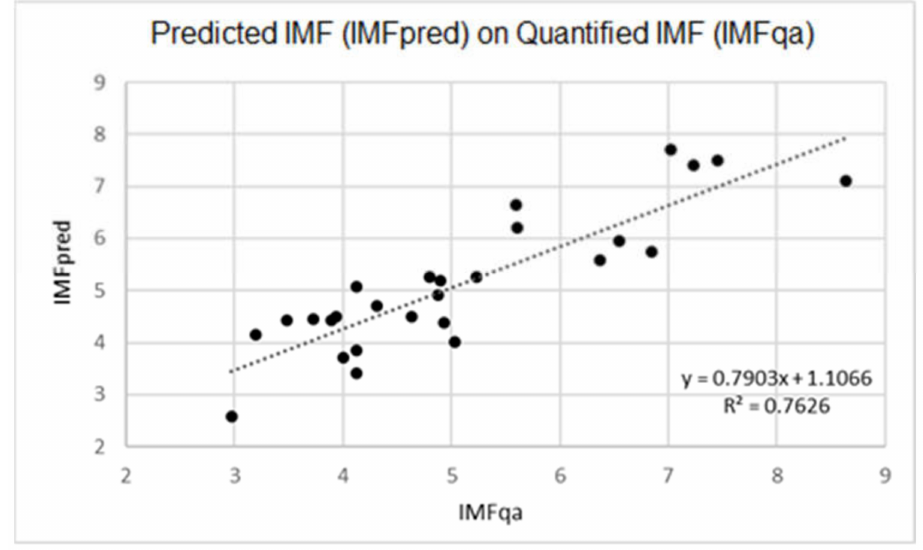
Figure 2. Scatterplot comparison of predicted IMF (IMFpred) and quantified IMF